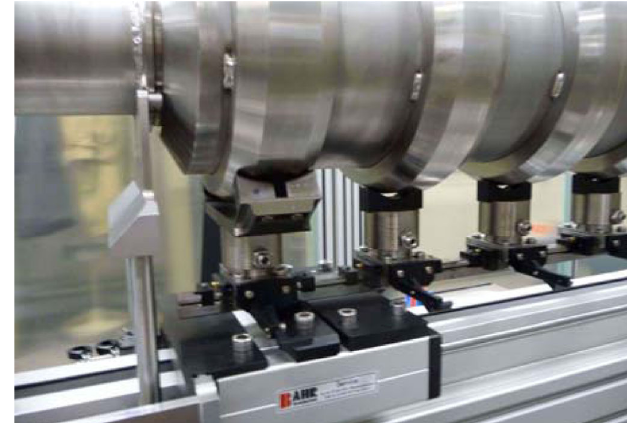
FIG. 19. (Color) Lift units and CT supports with the lift units at the left, contacting the reference plane. A dummy cavity is used to calibrate the eccentricity measurement